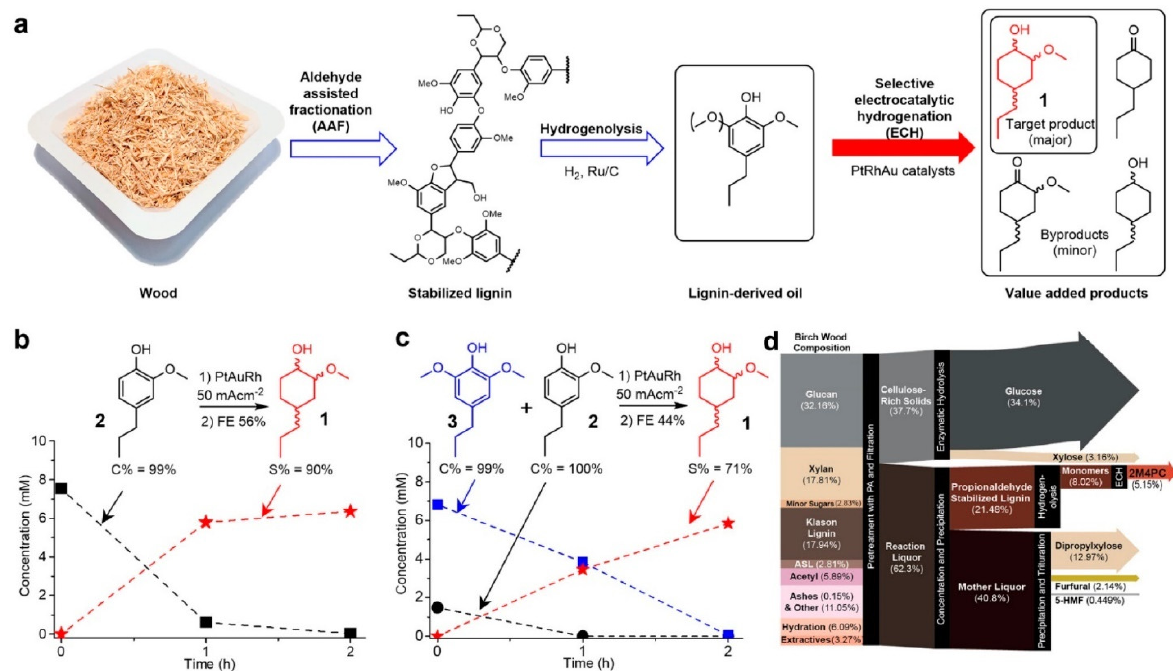
Figure 16. Integrated lignin valorization from wood to a methoxylated product 2-methoxy-4- propylcyclohexanol (2M4PC). ( a ) Integrated lignin valorization process for high-value 2M4PC from wood. 2M4PC (1, red) is the target structure in bold. ( b ) Concentration evolution of pinewood- de- rived lignin monomer 4-propylguaiacol (4PG) (2, black) and target product 2M4PC (1, red), showing an FE at 1 h reaction, conversion rate (C %), and product selectivity (S%) toward 2MC over 2 h ECH reaction. ( c ) Concentration evolution of birch-wood-derived lignin oil consisting of 4-propylsyringol (4PS) (3, blue) and 4PG (2, black) and target product 2M4PC (1, red), showing an FE at 1 h reaction, C%, and S% toward 2MC over 2 h ECH reaction. ( d ) Mass balances during the propionaldehyde-assisted fractionation of lignocellulosic biomass, as performed on birch wood. All the numbers are provided as weight percentages. The provided weight percentages of the sugars, stabilized sugars, furfural, 5-hydroxymethylfurfural (5-HMF), stabilized lignin, and lignin monomers have been corrected for the mass of the stabilizing group, hydration, dehydration, or hydrogenation to match their initial structure in the native biomass. Reprinted with permission from Reference [72]. Copyright 2018 American Chemical Society.